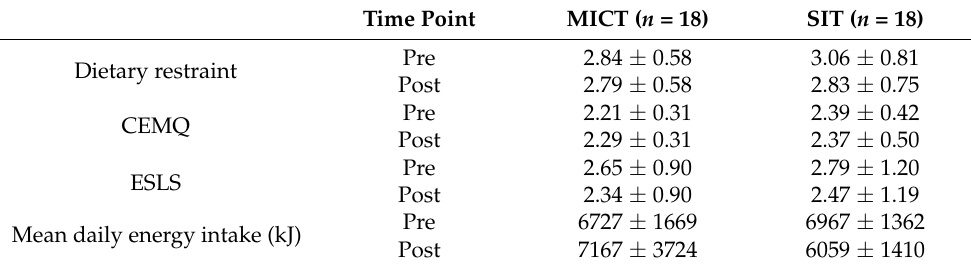
Table 3. Self-reported eating behaviors before and after 12 weeks of SIT or MICT (mean ± SD). Time